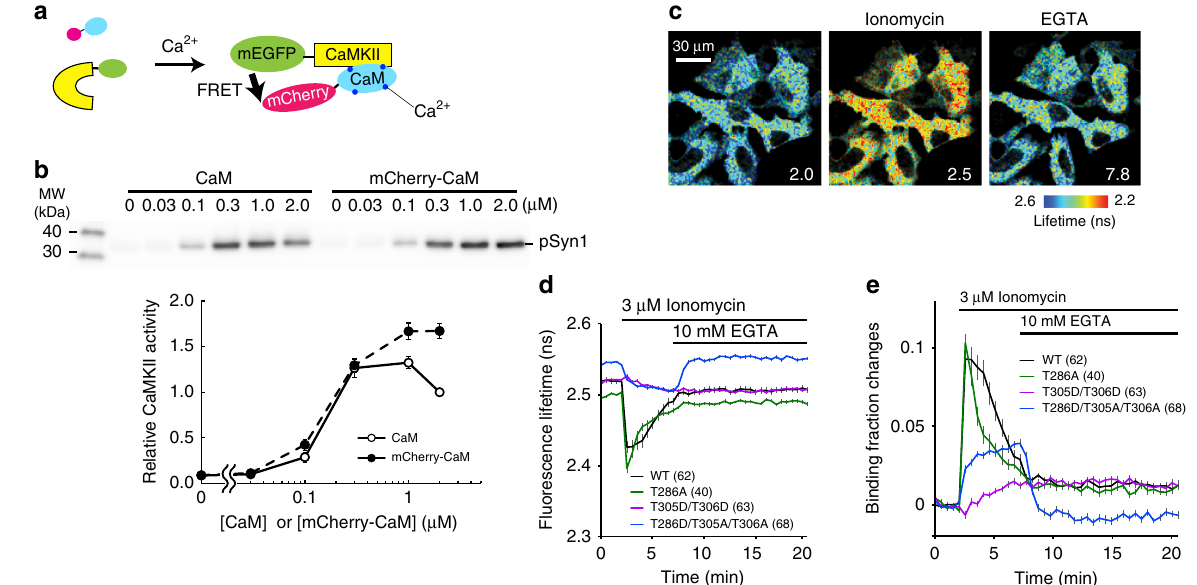
Fig. 1 Design and characterization of CaMKII α -CaM association sensor. a Design of a FRET sensor for CaMKII α -CaM association. Monomeric EGFP (mEGFP) and monomeric Cherry (mCherry) fl uorescent protein are fused to the N-terminus of CaMKII α and the N-terminus of CaM, respectively. b mCherry-CaM activates CaMKII α to the degree similar to non-labeled CaM at different concentrations of CaM in a cell-free system. Upper panel: western blot of phosphorylated Synapsin1 peptide (pSyn1) fused to mCherry. Lower panel: quanti fi cation of pSyn1 signal from 4 experiments, normalized with the pSyn1 signal at 2 µ M non-labeled CaM. c Fluorescence lifetime images of CaMKII α -CaM association sensor expressed in HeLa cells. d Time courses of fl uorescence lifetime of CaMKII α -CaM association sensor and its mutants (T286A, T305D/T306D and T286D/T305A/T306A) in response to bath application of ionomycin (3 µ M) and EGTA (10 mM). e Time courses of changes in CaMKII α -CaM association calculated from d . All data